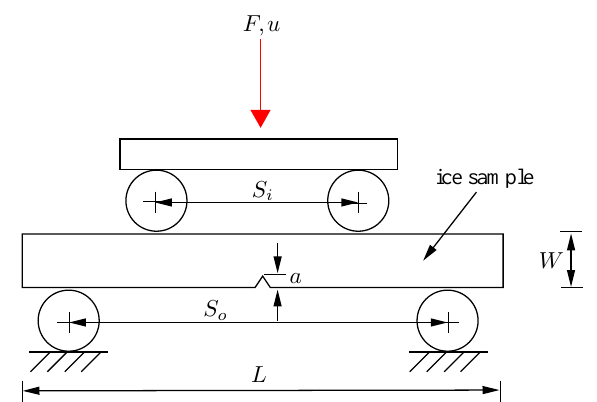
Figure 4. Depth-density profile of the considered ice core